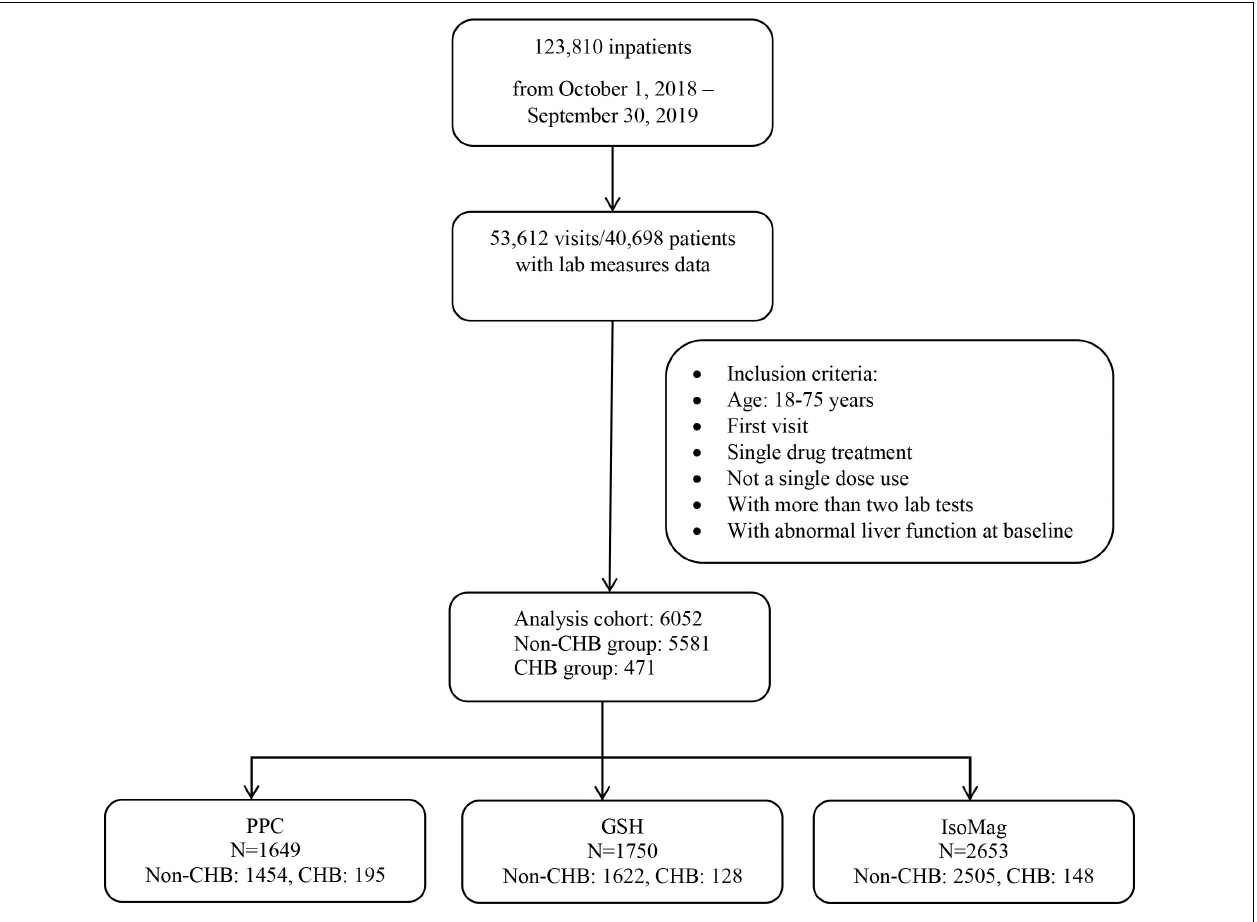
FIGURE 1 | A flowchart of patient